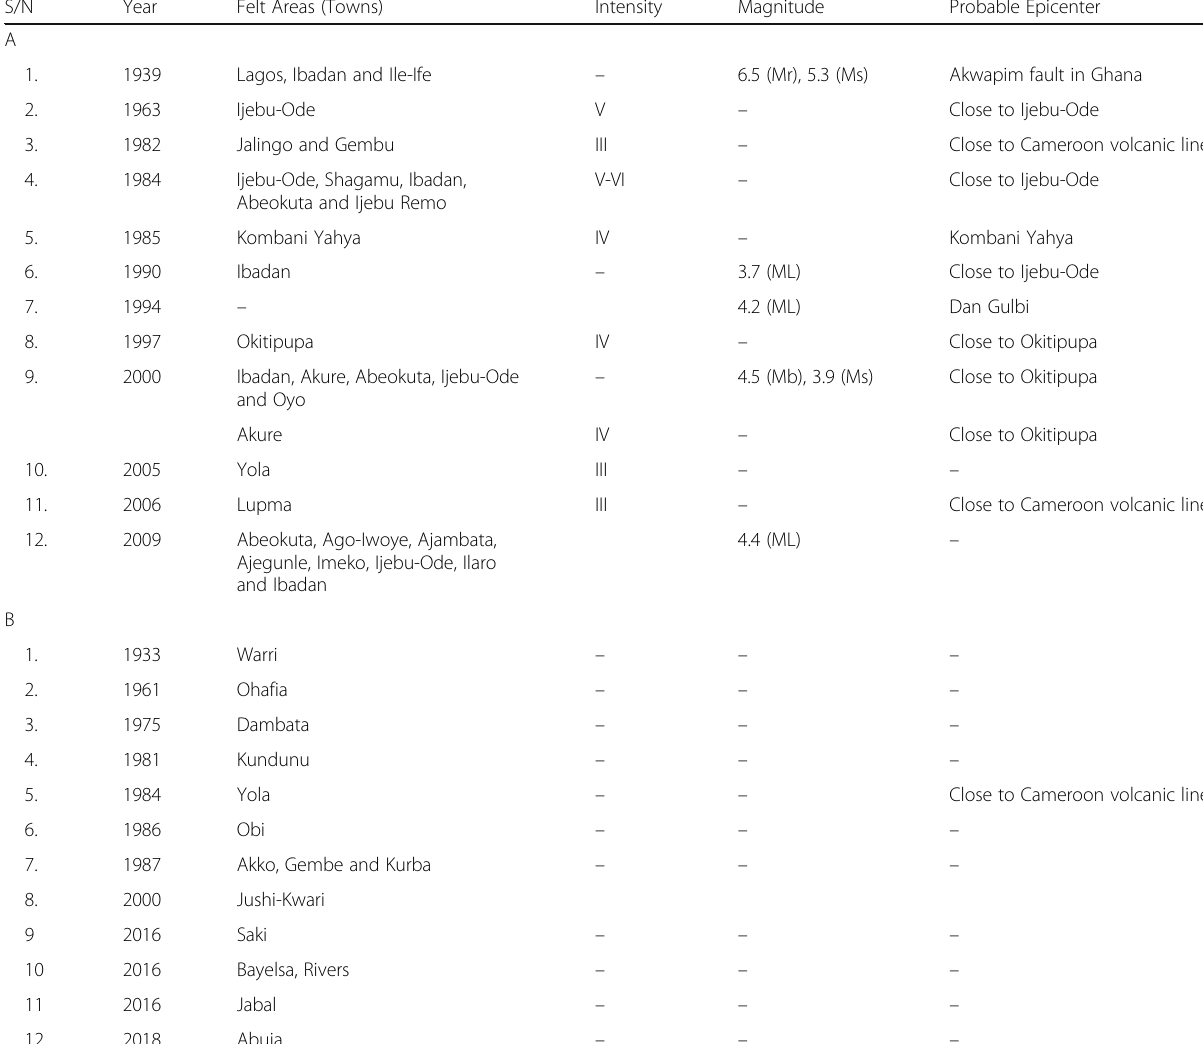
Table 6 List of Historical Earth Tremors in Nigeria (Adapted from Akpan and Yakubu 2010 and Eze et al. 2012) S/N Year Felt Areas